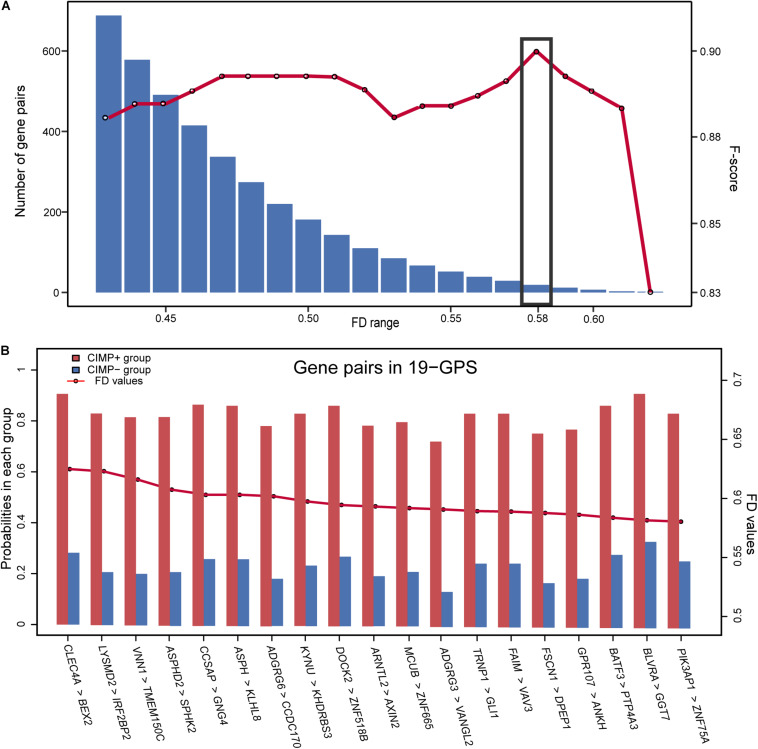
The F-score and number of the gene pairs within different range of FD values (A) and composition of 19-GPS (B). The x-axis represents the range of FD value and the relative expression orderings (REOs) (gene1 > gene2) of 19-GPS, respectively.